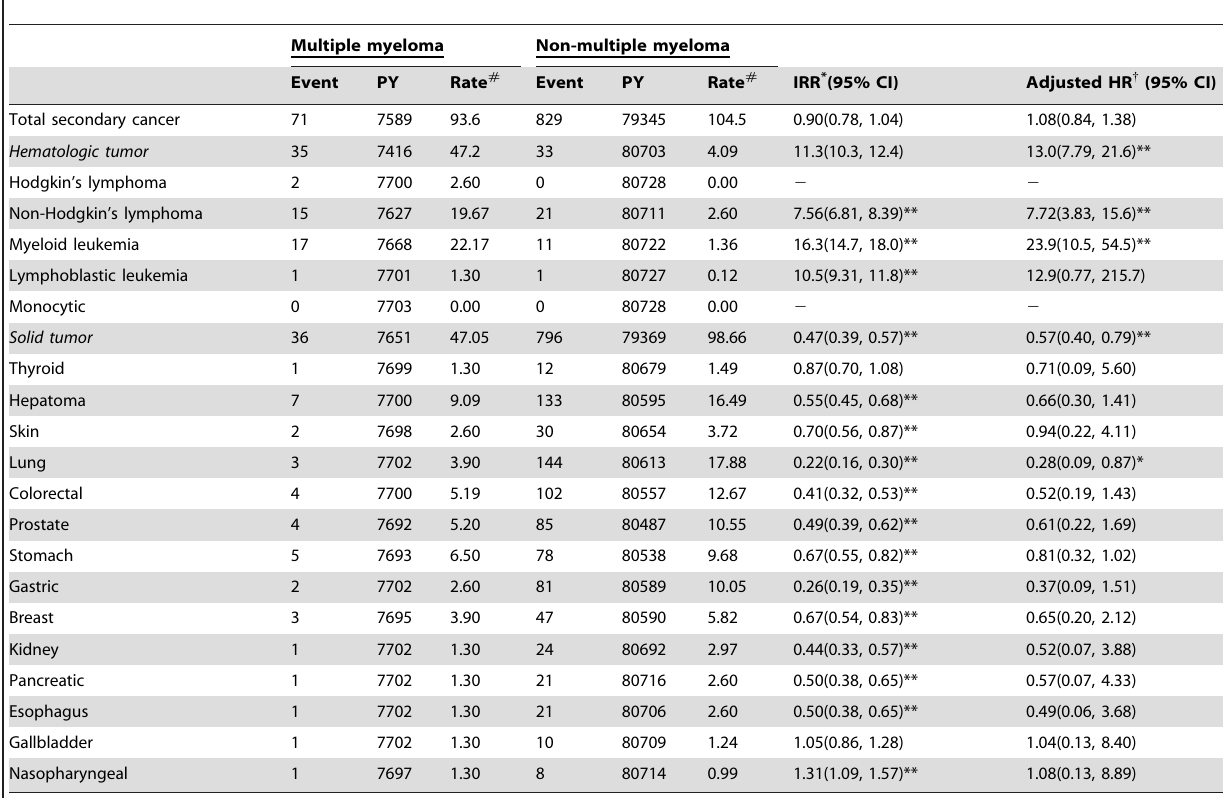
Table 2. Incidence, rate ratio, and adjusted hazard ratio of secondary cancer evaluated between patients with and without multiple